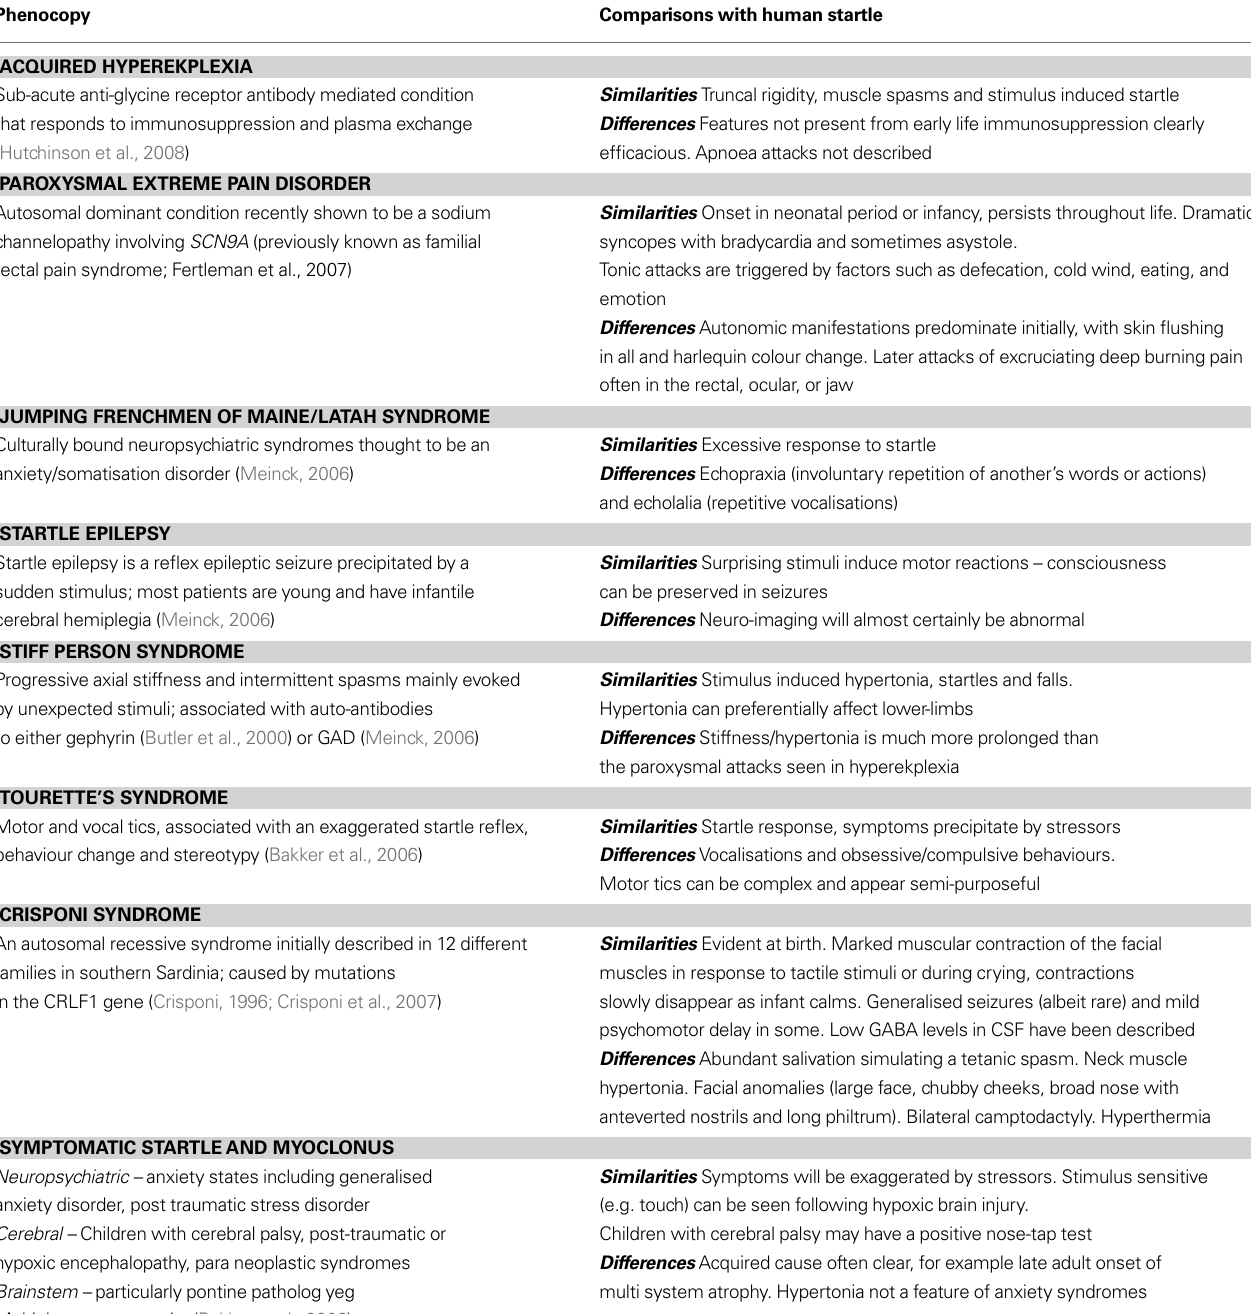
Table 2 | Clinical phenocopies of human